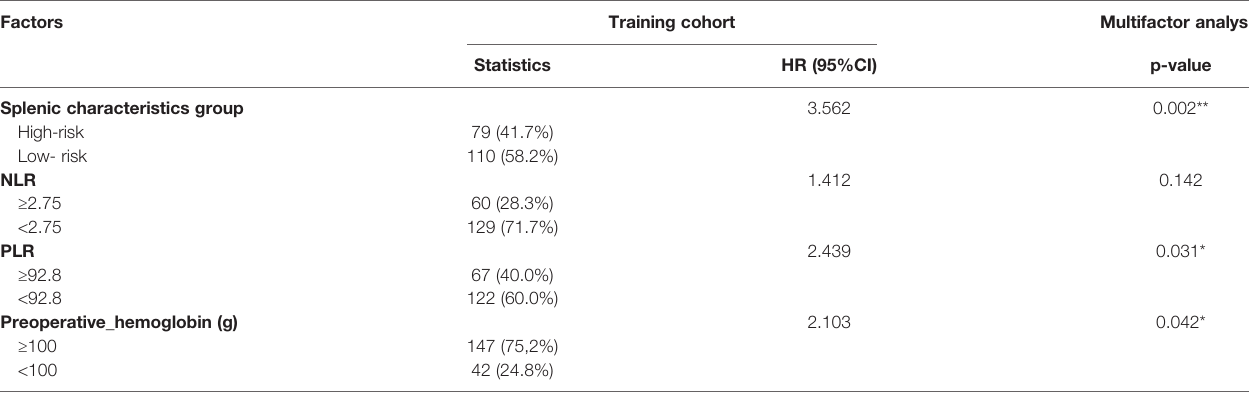
TABLE 4 | Multivariate analysis table of serosal